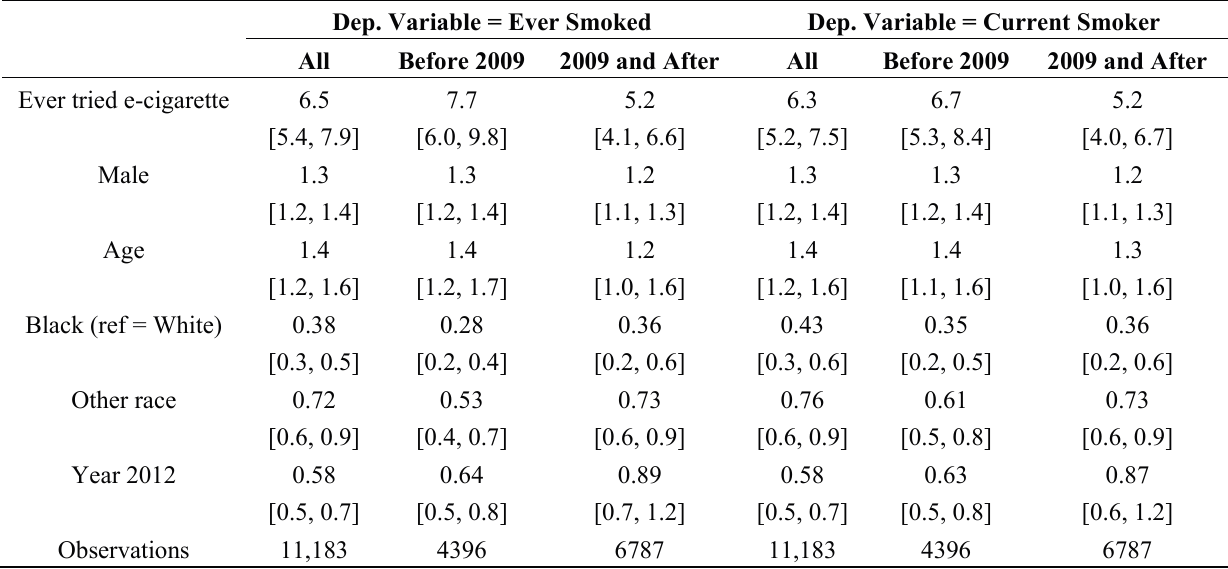
Table 4. Association of smoking and e-cigarette ever trying, by time of first trying a cigarette: before 2009 vs. later (ORs and 95% CIs).